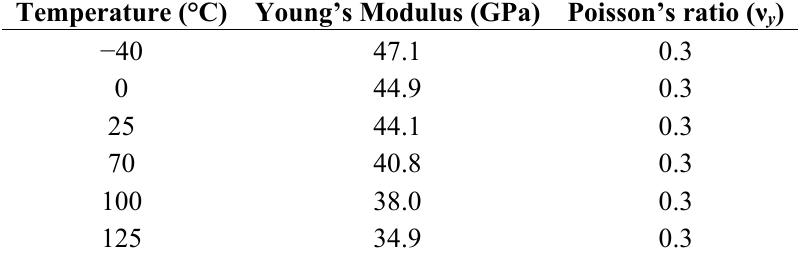
Table 2. Equivalent elastic mechanical properties of a microbump unit along the vertical